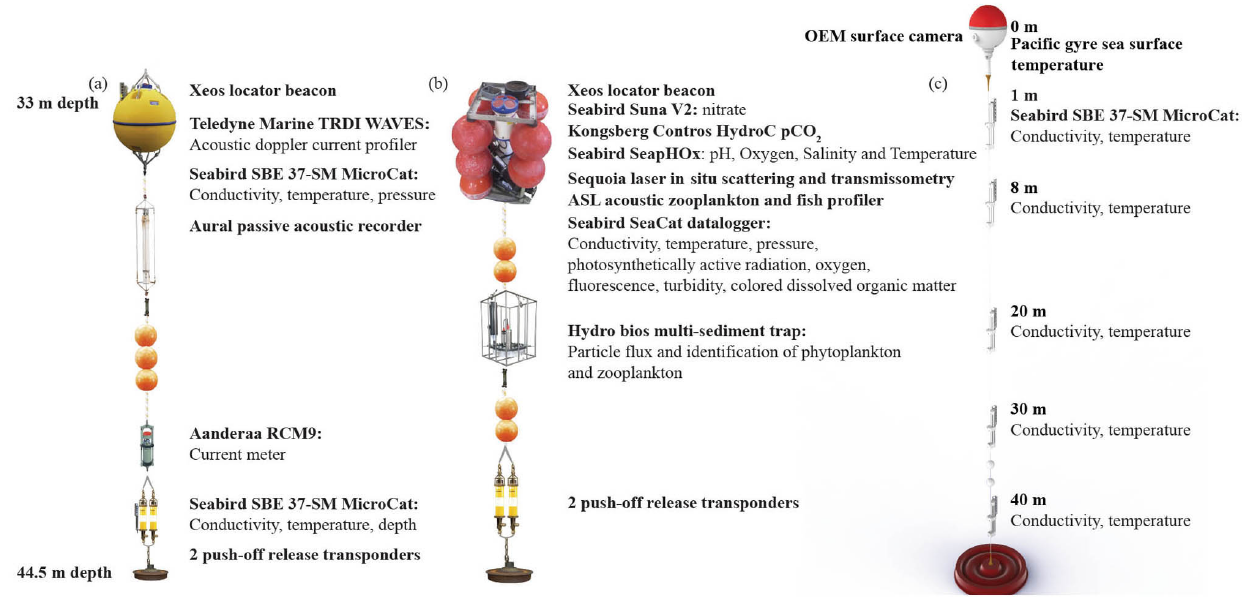
Figure 4. Illustration of the Chukchi Ecosystem Observatory (CEO), including the (a) biophysical, (b) biogeochemical, and (c) freeze-up moorings. Note that the freeze-up mooring includes a surface package, whereas the other two moorings only reach up to 33m depth. Sensors are calibrated with as many in situ samples as possible. Calibration samples are always collected upon deployment and recovery of the moorings and, depending on other research activity nearby our site, also at other times of the year. p CO 2 and pH sensors were added in summer